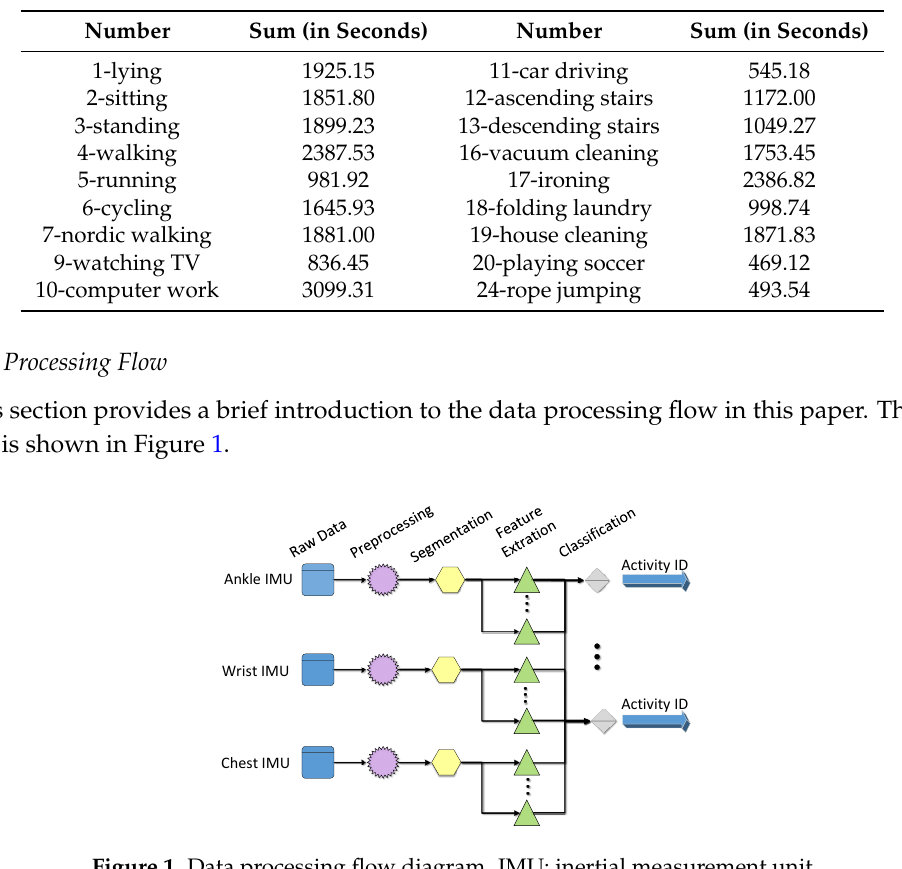
Figure 1. Data processing flow diagram. IMU: inertial measurement unit.